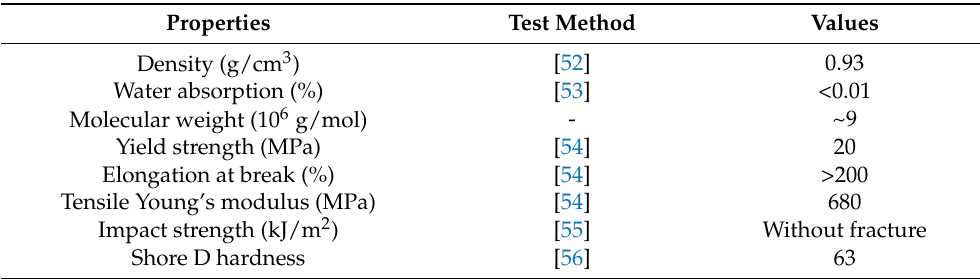
Table 13. The properties of the ‘Polystone ® M natural’ material fabricated by ‘Röchling Engineering Plastics’ [51].